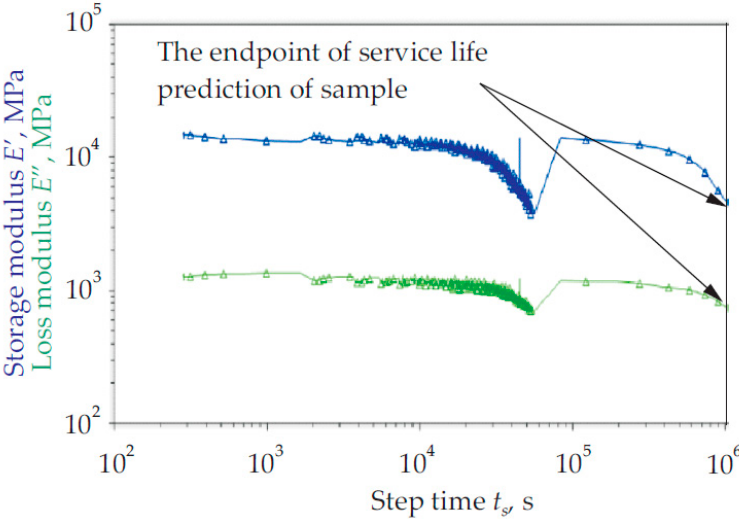
Figure 3. Master curve of both pultruded composite samples at 95 °C, which indicates 25 years